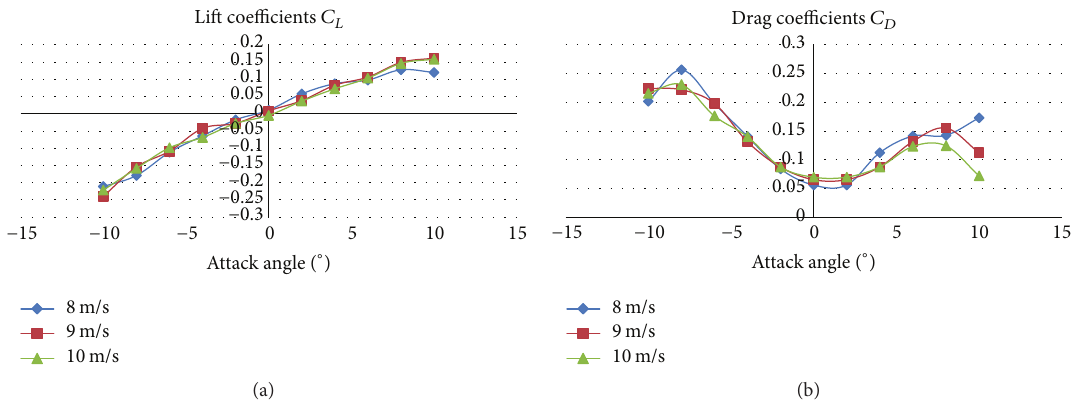
Figure 3: Aerodynamic force coefficients: (a) lift coefficient 𝐶 𝐿 and (b) drag coefficient 𝐶 𝐷